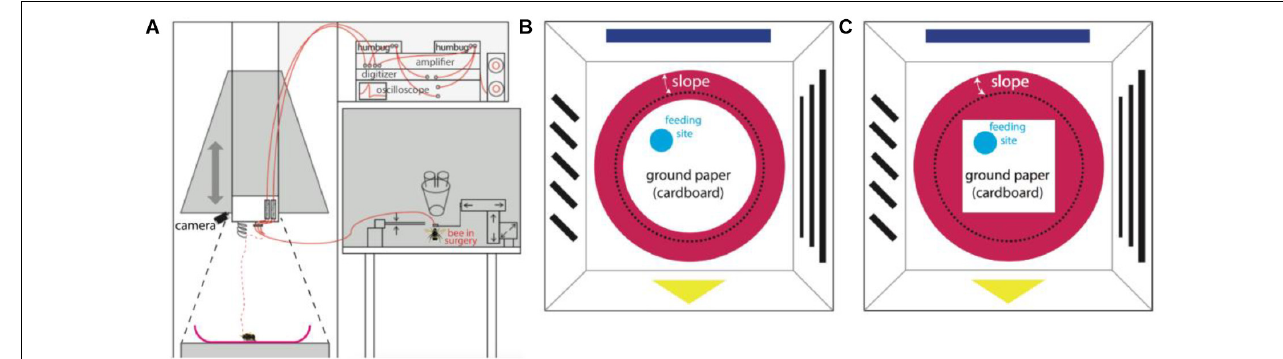
FIGURE 1 | Experimental set-up. (A) Recording set-up. A sketch of the whole apparatus modified from Duer et al., 2015. The set-up was composed of an artificial arena environment for behavioral and neural recordings (left half) close to a neural set-up for dissecting the brain, inserting the electrodes, testing for unit activities and for storing neural data (right half). The surgery was done on the table to the right under binoculars. The pyramid hanging over the left part was designed as a Faraday cage and could be lowered down to the ground forming an enclosed space and well shielded. Neural signals were picked up by two twisted 15 µ m diameter copper wires and a silver 50 µ m diameter ground wire and transmitted to two amplifiers (red lines), an oscilloscope, a pair of loud speakers, an analog-digital converter, and finally stored in a computer. The dashed red line shows the electrode after releasing the bee on ceramic plate, while the black dashed line marks the position when the hanging pyramid was lowered to the ground. (B) The bird’s eye view of the arena environment (AE) with round ground paper (when the pyramid containing panorama patterns was on the ground). A video camera mounted on the ceiling recorded the movements of the bee. Simple patterns were pasted on the inner white walls as panorama. A red ceramic plate was placed in the center of the ground. A piece of round white cardboard paper (diameter 22 cm) was fixed to center of the plate; the edge of the white paper was 1 cm away from the lower end of the slope (black dashed line). Fresh sucrose solution (50% in volume) was supplied on a tiny blue feeding disk. The location of the feeding disk was changed from bee to bee, but was always between the center and the edge of ground paper. (C) The bird’s eye view of the AE with squared ground paper (diagonal 22 cm). This experimental condition only applied to bee #